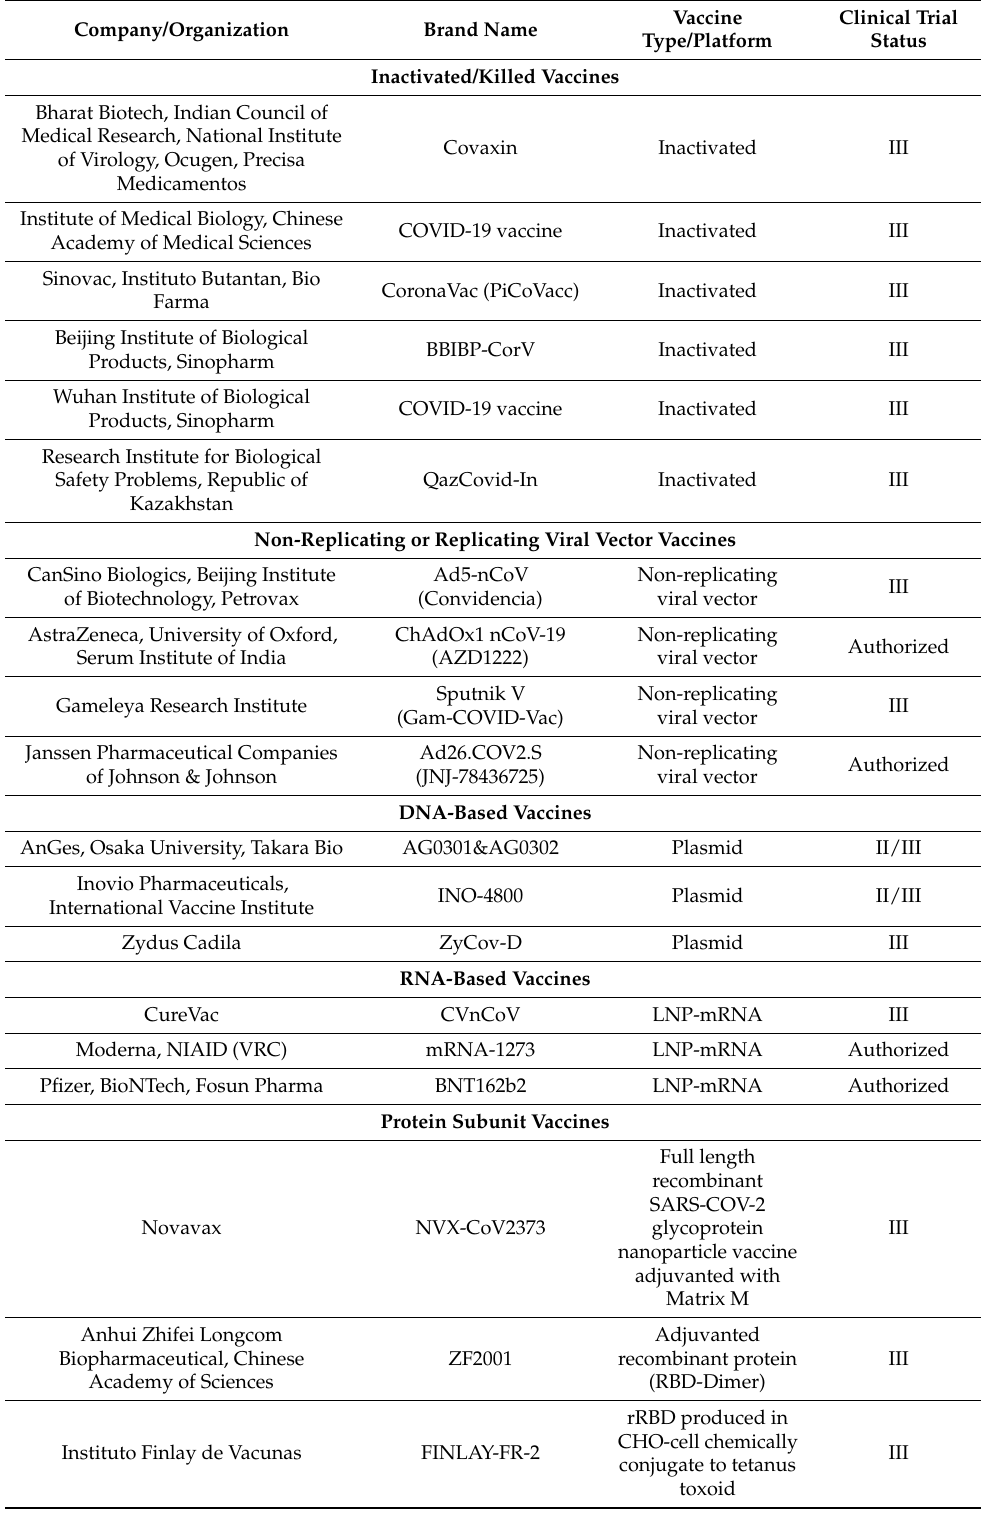
Table 1. COVID-19 vaccines currently in clinical trials or